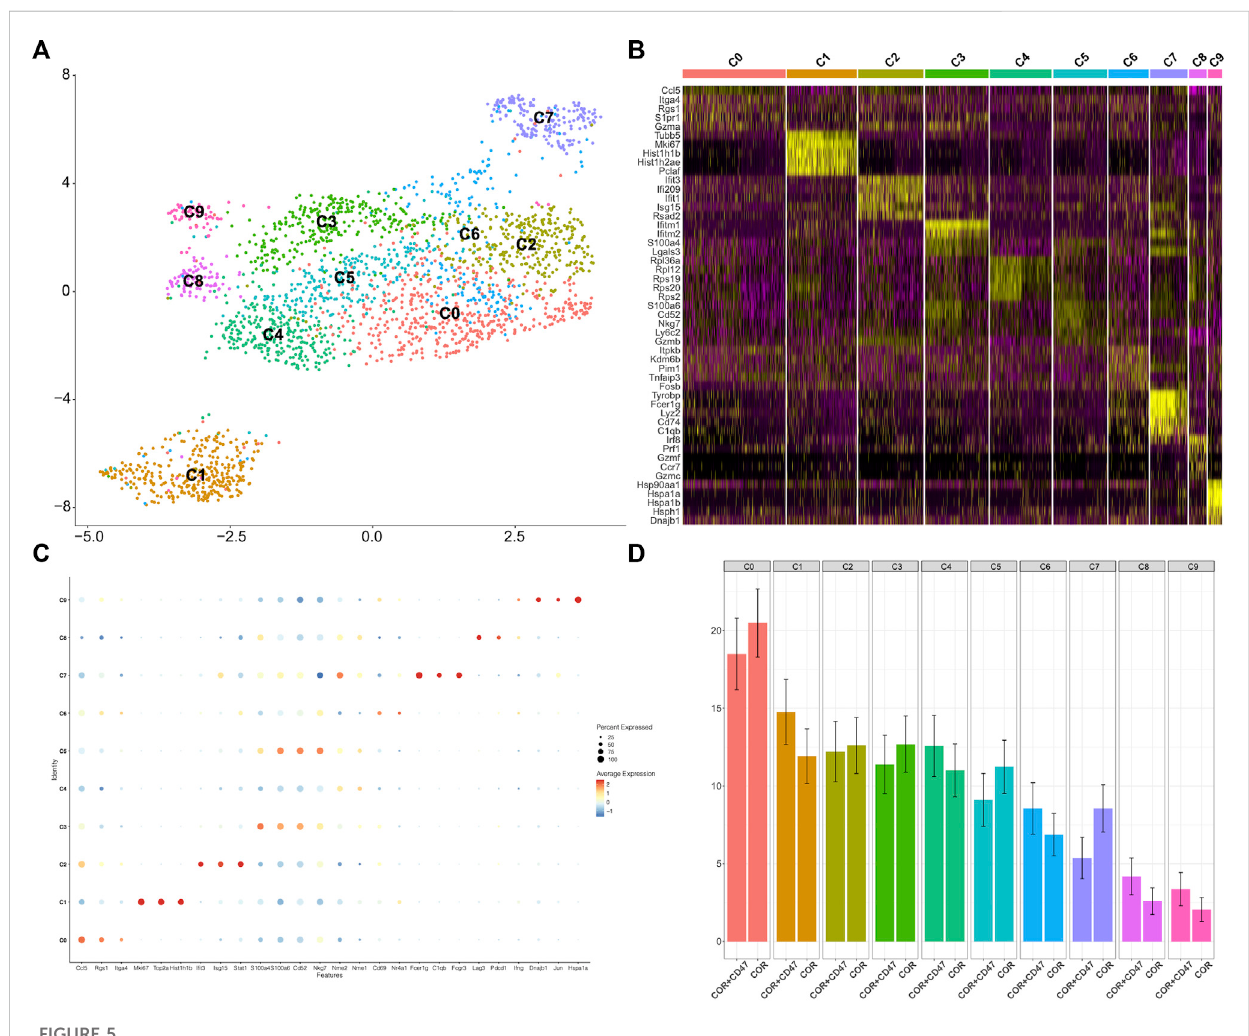
FIGURE 5 scRNA-seq analysis is used to test the changes of CD8 + T cells (A) . UMAP plots of the scRNA-seq dataset show sub-clustering of CD8 + T cells (B) . Individual CD8 + T-cell clusters in the scRNA-seq data could be identi fi ed phenotypically based on a heatmap of CD8 + T-cell lineage and functional markers (C) .A dotplotshowedtheexpressionlevels andactivityscores ofknownphenotypicmarkersineachCD8 + T-cellcluster (D) .Theproportionsof different subpopulations of CD8 + T cells are shown by bar graphs in MC38 tumors from the combination treatment group or cordycepin